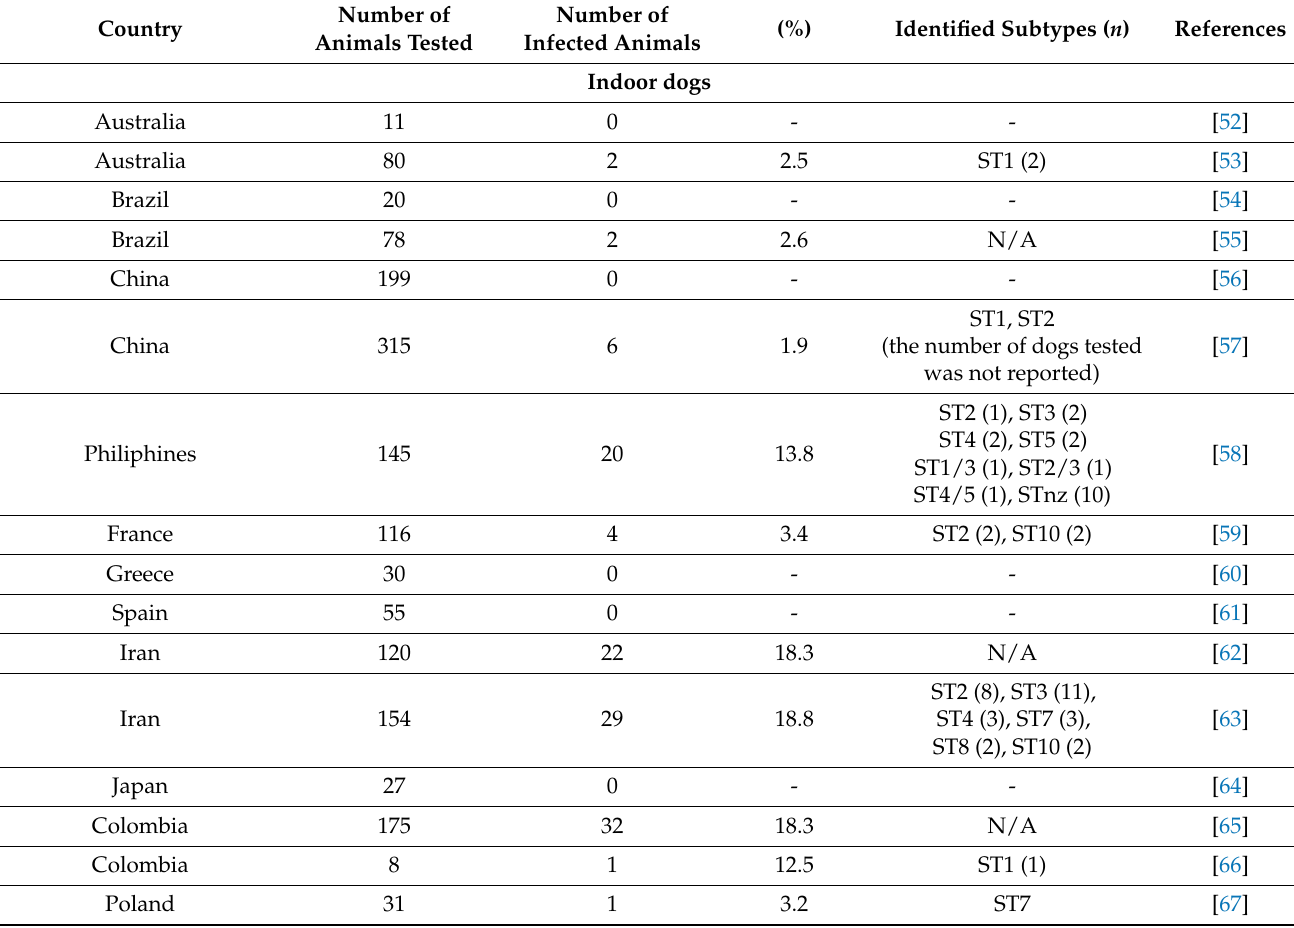
Table 1. Infection rates and subtypes of Blastocystis identified in dogs from different countries, grouped according to the living conditions of the